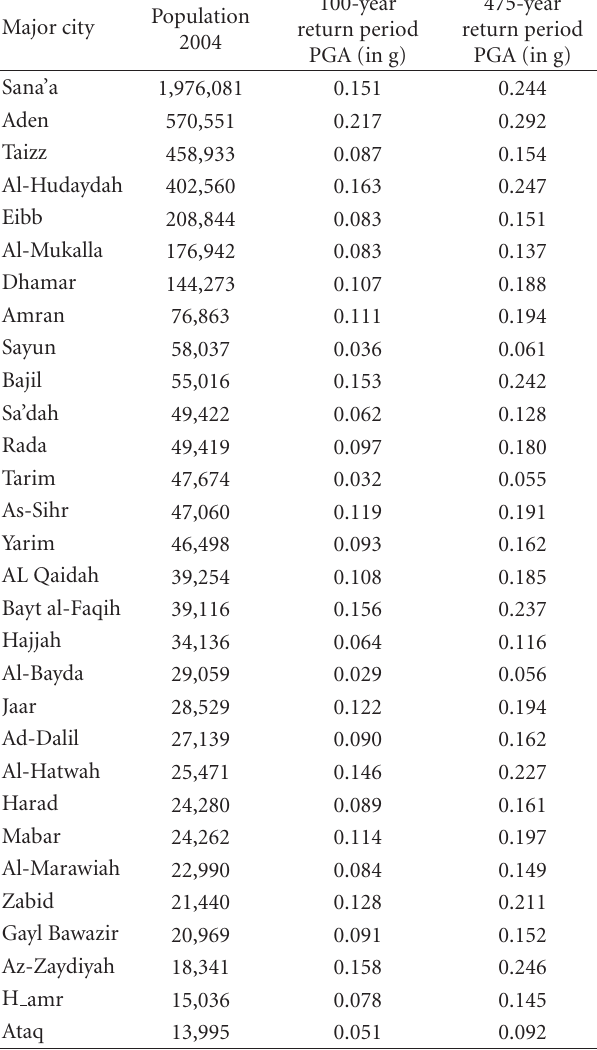
Table 6: Estimated probabilistic seismic hazard for 100- and 475- year return periods for major cities in